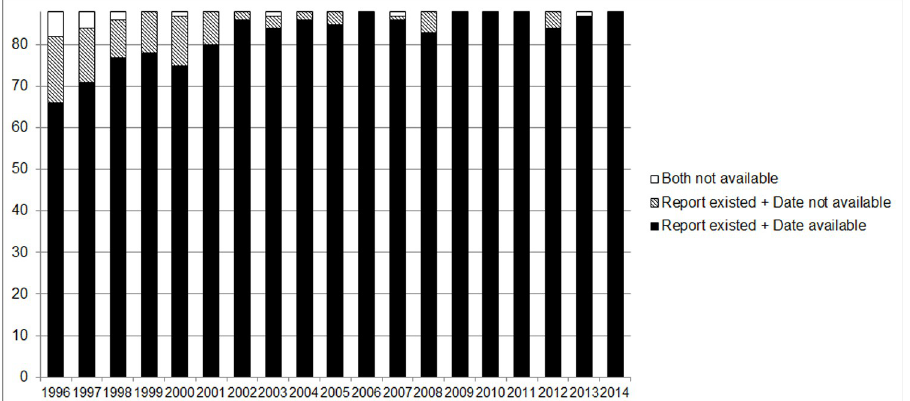
Fig 1. Existence of quarterly report and receipt date available. The Provincial Health Office of Palawan was supposed to annually receive 88 quarterly reports from its catchment 22 health centers. The breakdown of the stacked bar chart is the number of quarterly reports that existence was confirmed and receipt dates were available, the number of quarterly reports that existence was confirmed, but receipt dates were not available, and the number of quarterly reports that existence was not confirmed and receipt dates were not